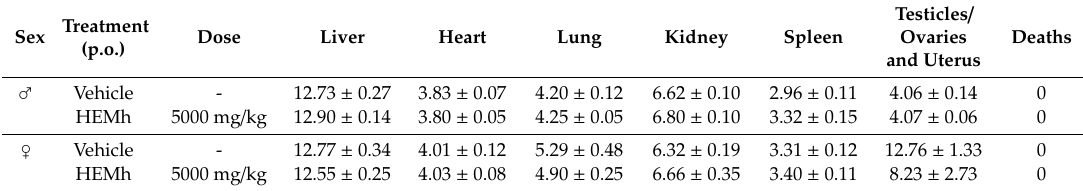
Table 2. Toxicological parameters after the acute administration (5000 mg / kg) of hydroalcoholic extract of the twigs of Machaerium hirtum (HEMh) in adult Swiss mice through the oral route ( n = 10). Treatment Sex